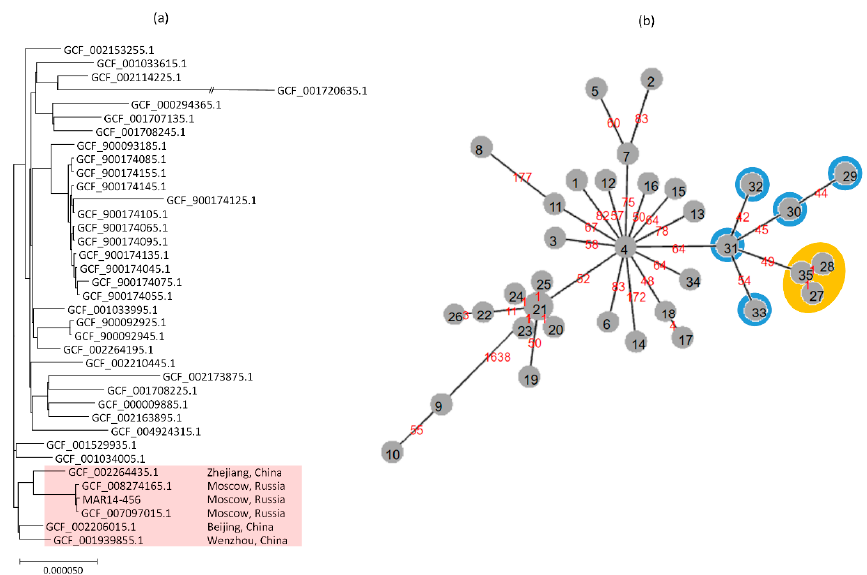
Figure 1. ( a ) Maximum likelihood tree for cgSNP analysis of ST23 K. pneumoniae isolates ( b ) Minimum-spanning tree (MST) of cgMLST allelic profiles of ST23 isolates. The node numbers on MST